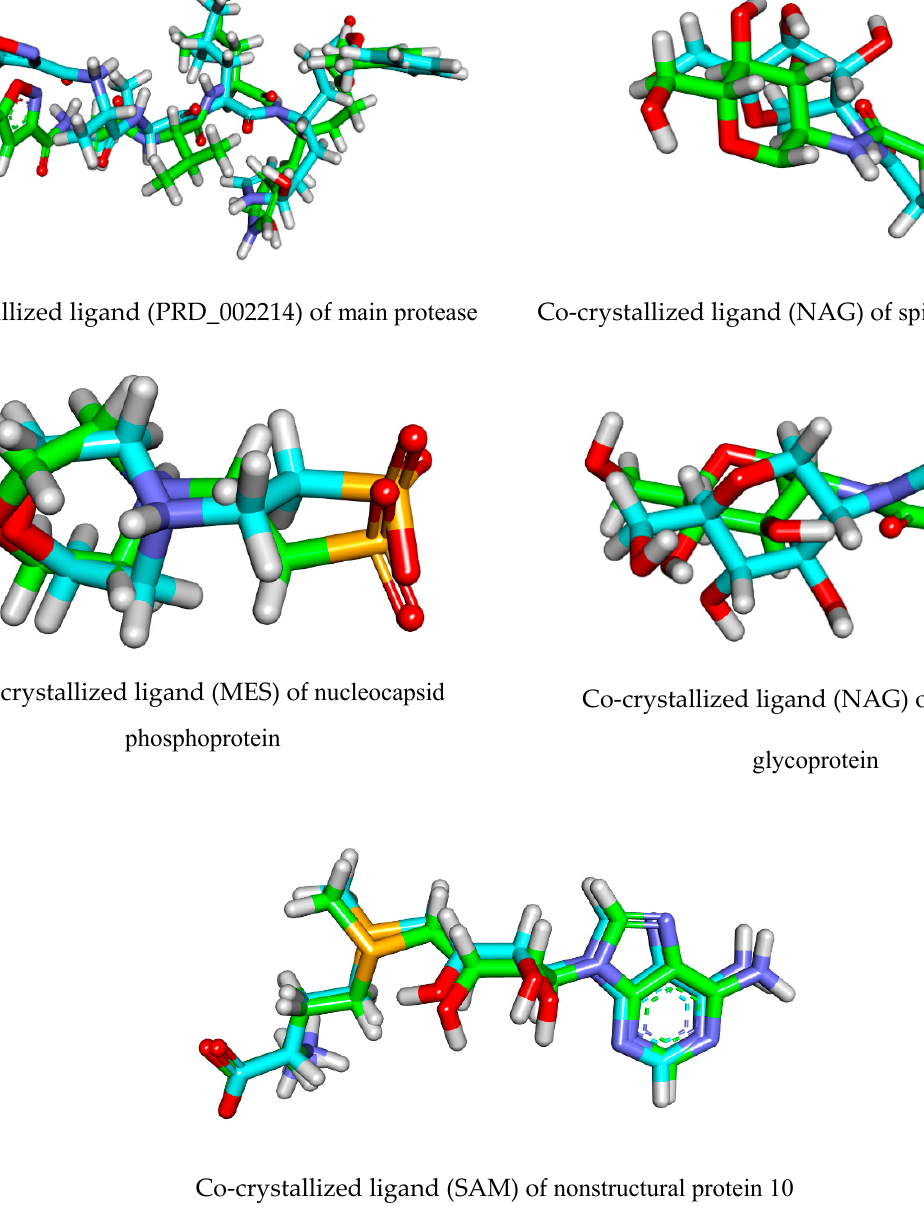
Figure 2. Superimposition of the co-crystallized poses (green) and the docking poses (maroon) of the same ligands. Docking studies, in general, showed robust binding energies for all compounds tested with a noticeable superiority for pentacyclic compounds. The pentacyclic guani- dines, crambescidins 786 ( 5 ) and 826 ( 13 ) exhibited the greatest free energy of docking. Crambescidin 786 ( 5 ) showed promising binding affinities against COVID-19 main protease ( ∆ G = − 8.05 kcal/mol), nucleocapsid phosphoprotein ( ∆ G = − 6.49 kcal/mol), and nsp10 ( ∆ G = − 9.06 kcal/mol), compared to the co-crystallized ligands PRD_002214 ( ∆ G = − 8.18 kcal/mol), MES ( ∆ G = − 3.80 kcal/mol), and SAM ( ∆ G = − 5.77 kcal/mol), respectively. In addition, crambescidin 826 ( 13 ) showed good binding affinities against the COVID-19 main protease ( ∆ G = − 7.99 kcal/mol), spike glycoproteins ( ∆ G = − 6.95 kcal/mol), and nucleocapsid phosphoprotein ( ∆ G = − 8.01 kcal/mol), compared to the co-crystallized ligands PRD_002214 ( ∆ G = − 8.18 kcal/mol), NAG ( ∆ G = − 3.56 kcal/mol), and MES ( ∆ G = − 3.80 kcal/mol), respectively (Table